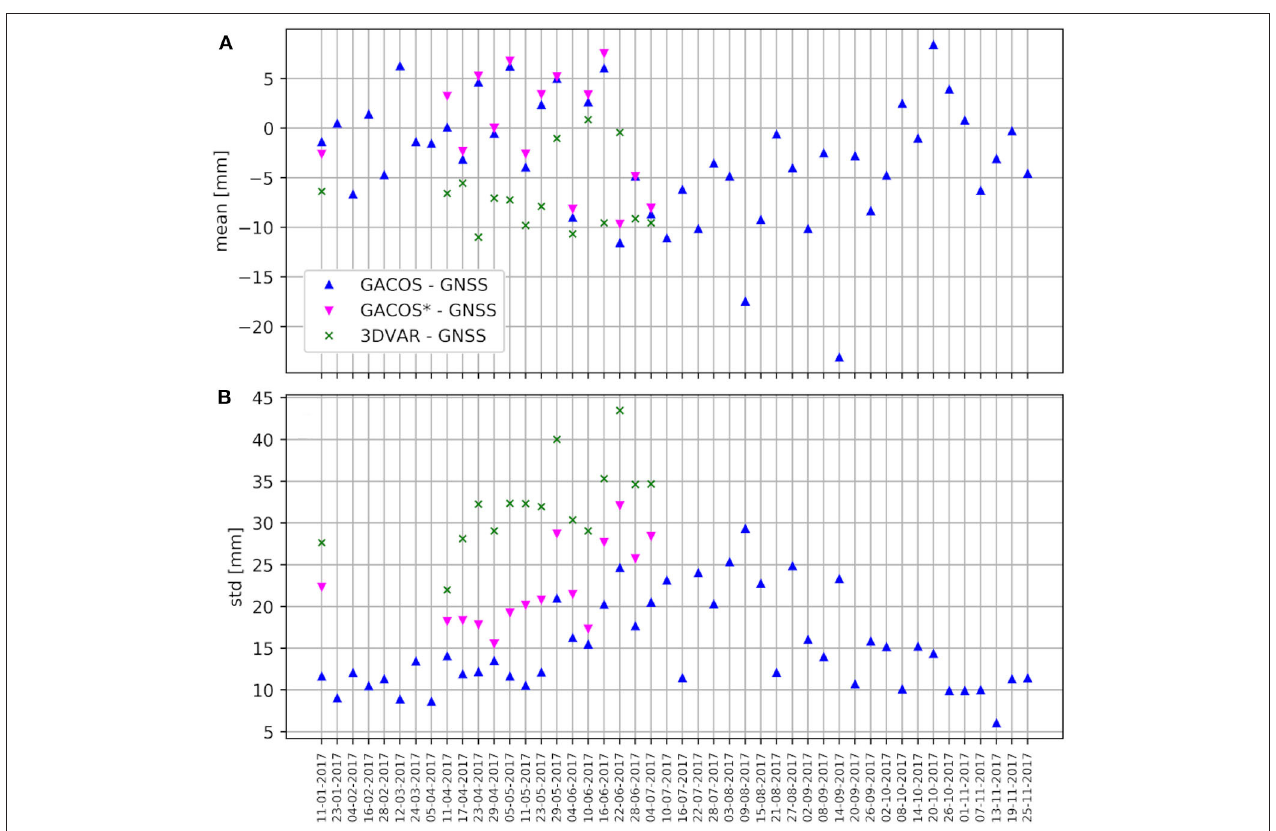
FIGURE 7 | Time series of the spatial statistics of the differences between model ZTDs and GNSS ZTDs: mean values in (A) and standard deviation in (B) .